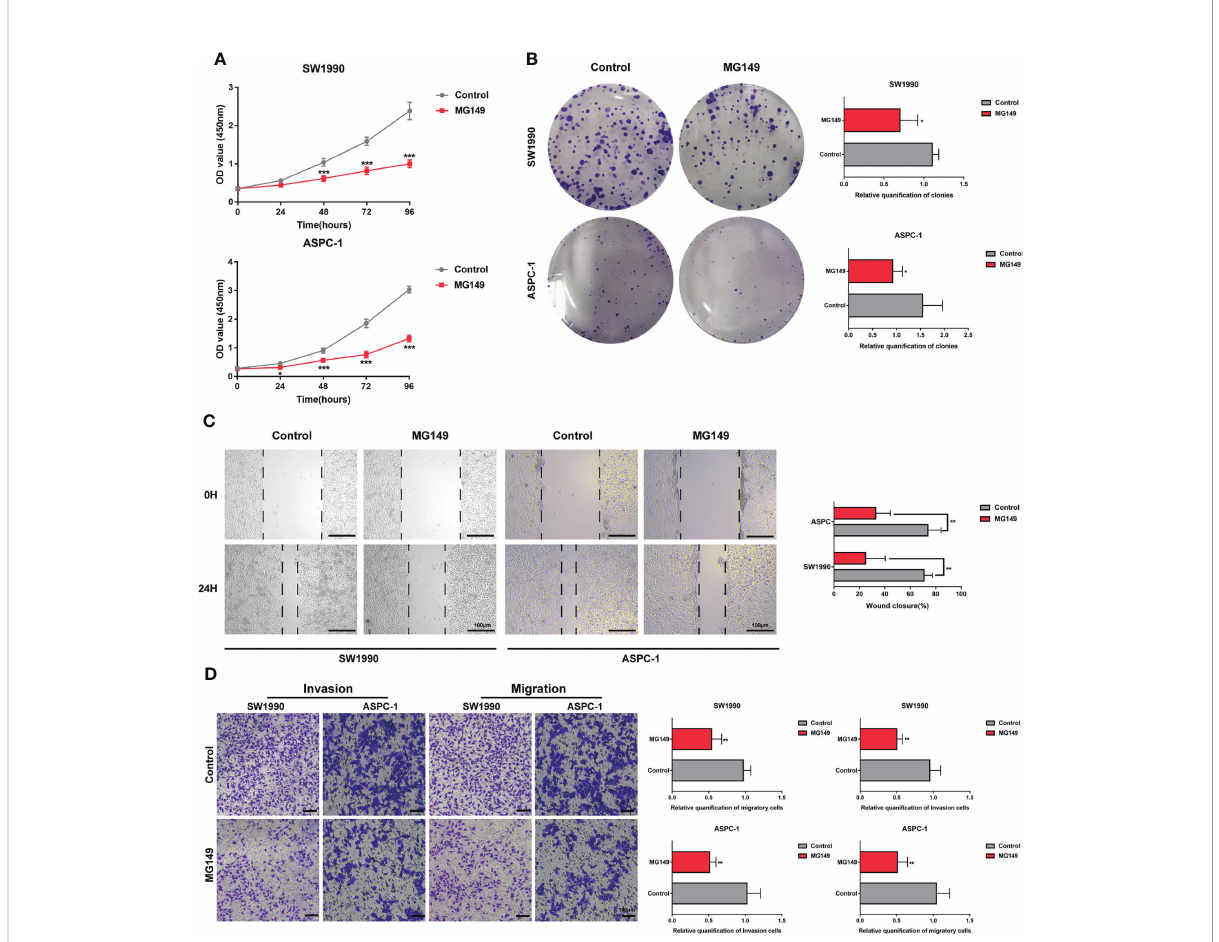
FIGURE 7 MG149 suppressed PC proliferation, migration, and invasion. (A) CCK8 assay was performed to measure the proliferation ability of PC cells. (B) Representative images of the colony formation assay of the SW1990 and ASPC-1 cells with or without MG149 (74 m M) treatment and culture in a complete culture medium for 14 days. (C) Representative images of the wound healing assays of the SW1990 and ASPC-1 cells with or without MG149 (74 m M) treatment, Scale bar: 100 m m. (D) Transwell assays were performed to examine the effect of MG149 on PC cell migratory and invasion ability. Scale bar: 100 m m. * P <0.05, ** P <0.01, *** P